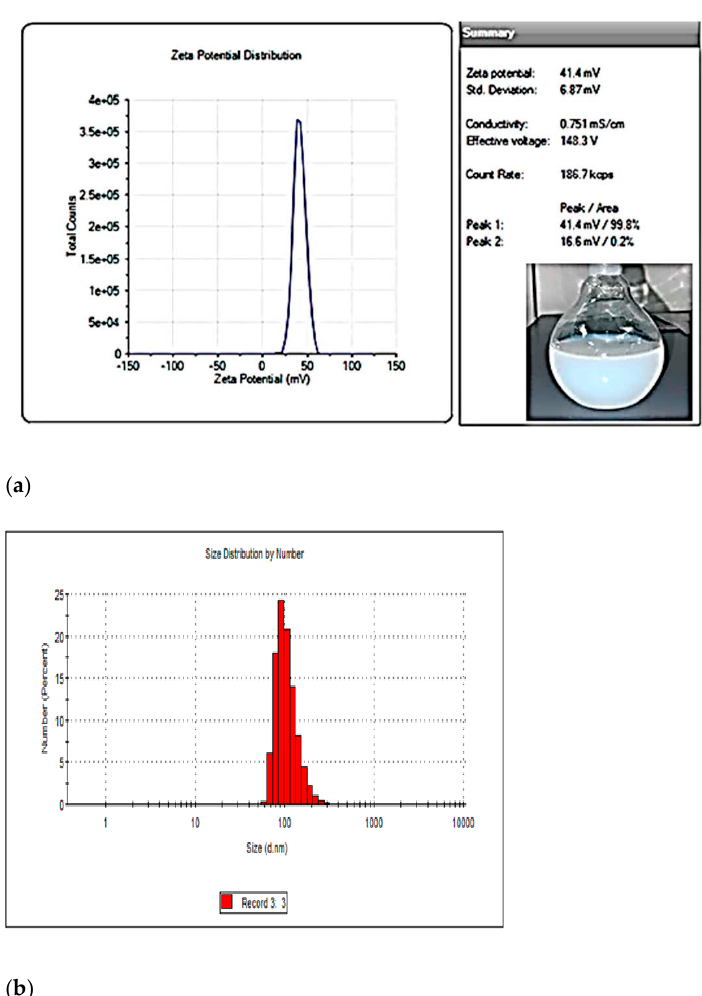
Figure 4. Colloidal stability of MIP-202 nanoparticles. ( a ) Zeta potential of MIP-202 nanoparticles, ( b ) Dynamic light scattering number analysis of MIP-202 nanoparticles .